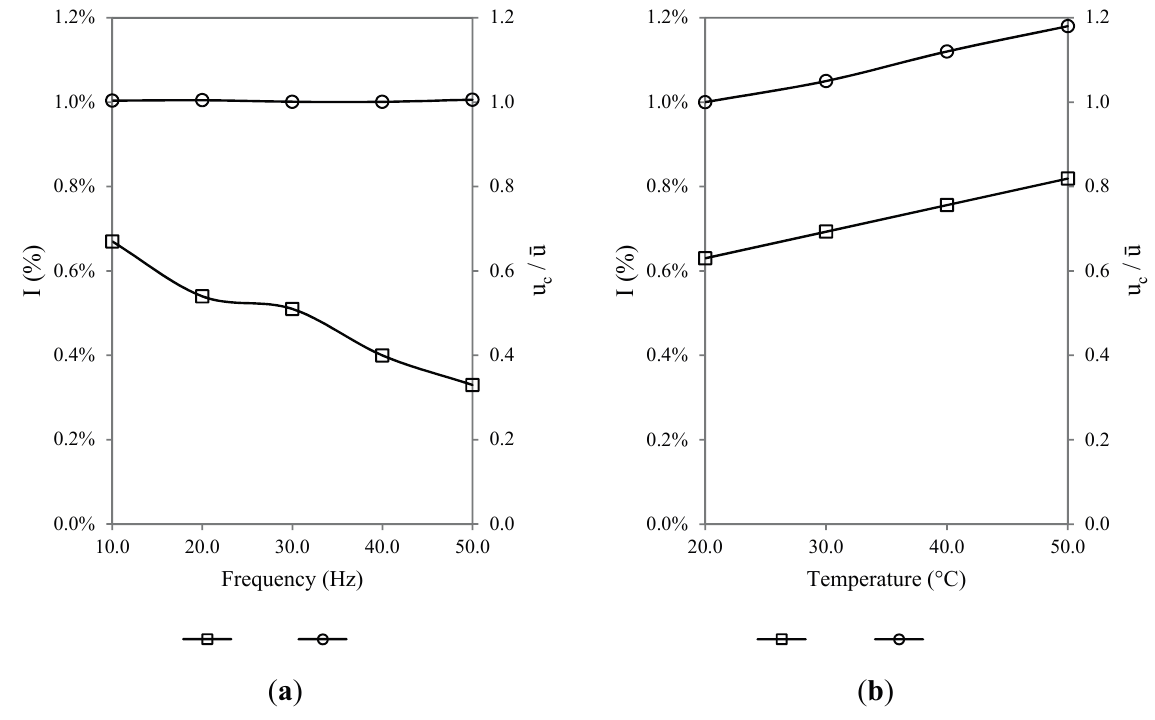
Figure 10. Variation of u /u(cid:3364) and I(%) at ( a ) increasing fan frequencies and ( b ) increasing (cid:2913) operating